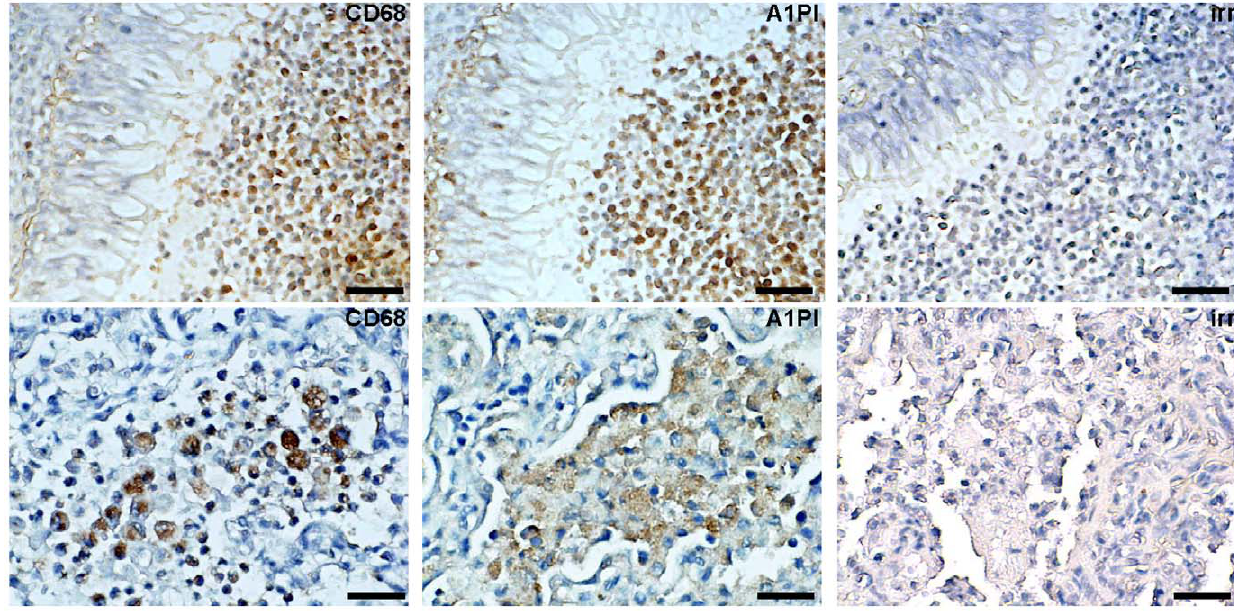
Figure 1. Cell Associated A1PI Detection in Human Lung Tissue. Lung tissue acquired at autopsy from patients with advanced lung disease associated with cystic fibrosis (n=8, top row) and acute fatal respiratory syncytial virus infection (n=9, bottom row). Representative detection of macrophage antigen CD68 (left panels), A1PI (middle panels), or irrelevant species-matched control antibody (right panels) are shown. Bar=30 m m top row, 15 m m bottom